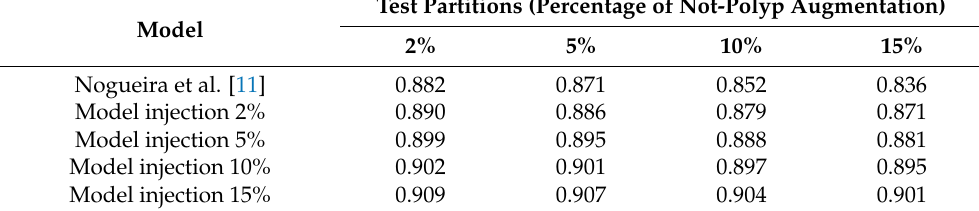
Table 4. Precision metrics obtained with different models against different not-polyp injections into the original test partition.